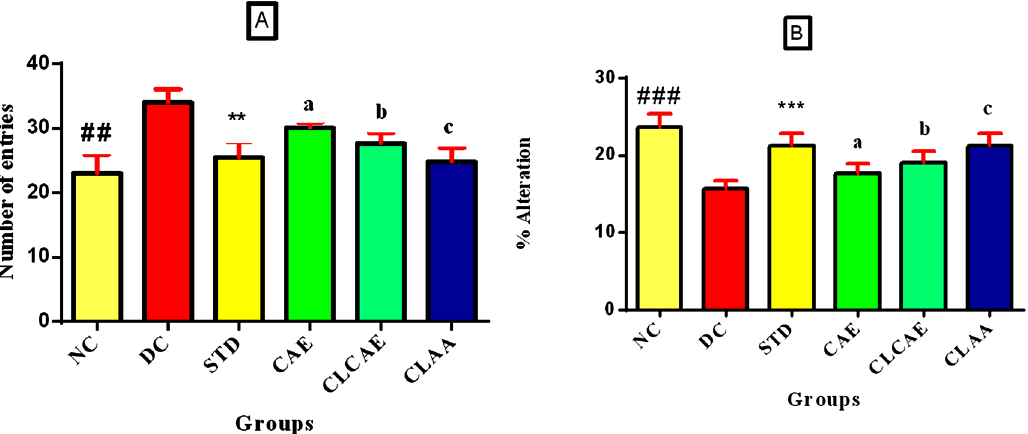
Figure 9. Y-Maze test. Note (bottom) Figure 9A: Data represented as mean (cid:3) SD. Statistical analysis was performed one way ANOVA followed by Bonferroni multiple comparison tests. ## p< 0.05 , ** p< 0.05, b p < 0.01, c< 0.01 when compared to disease control. Note (bottom) Figure 9B: Data represented as mean (cid:3) SD. Statistical analysis was performed one way ANOVA followed by Bonferroni multiple comparison tests. ## p< 0.01 , ** p< 0.05, b p < 0.01, c< 0.01 when compared to disease percentage alternations. 73 Thememoryretention activity ofgroups III, IV,V, andVI interms of thenumber ofarmentries